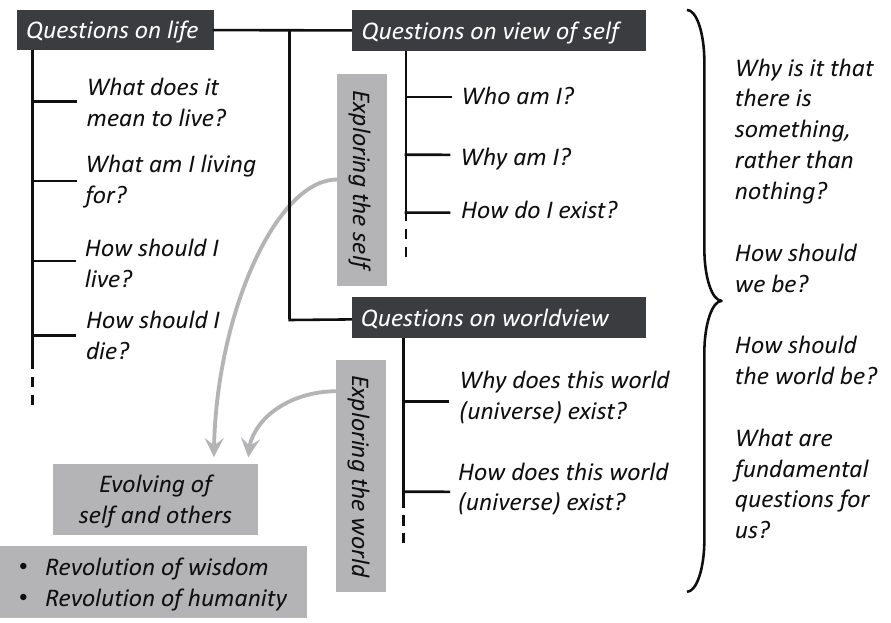
Figure 5. An overview of exploring the self and others, ourselves and the world (universe), and humanity and